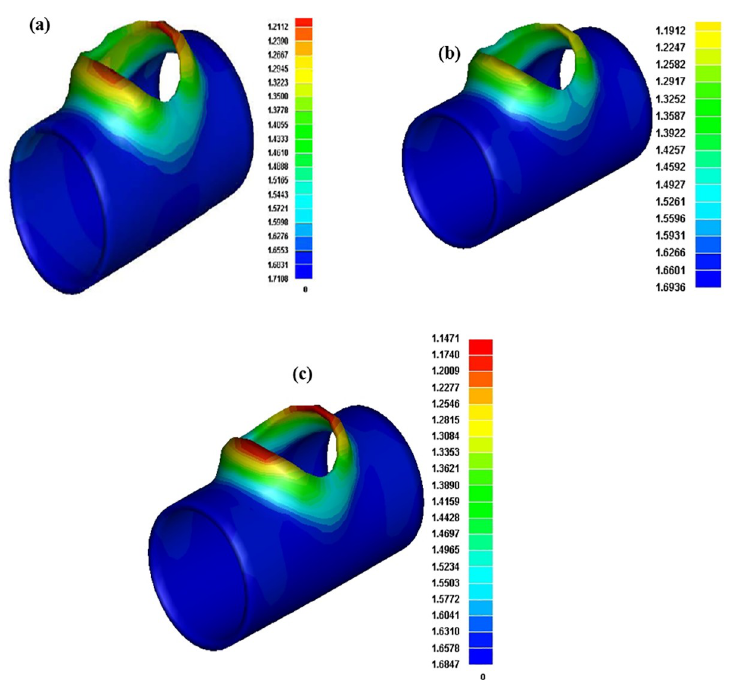
Fig 15. Distribution of tube thickness from FEA simulation a) Case 1 b) Case 4 c) Case 7.